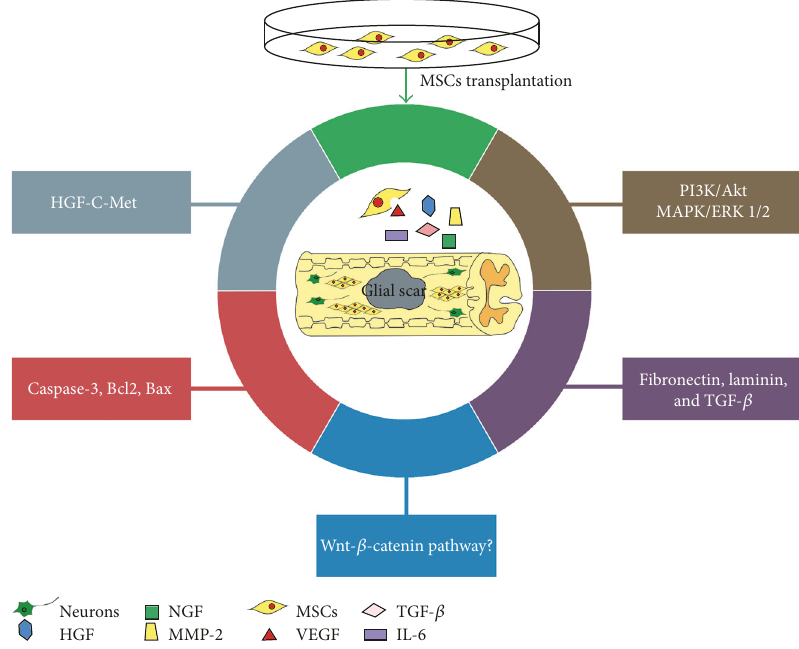
Figure 2: Regulatory molecular mechanisms involved in SCI after MSC